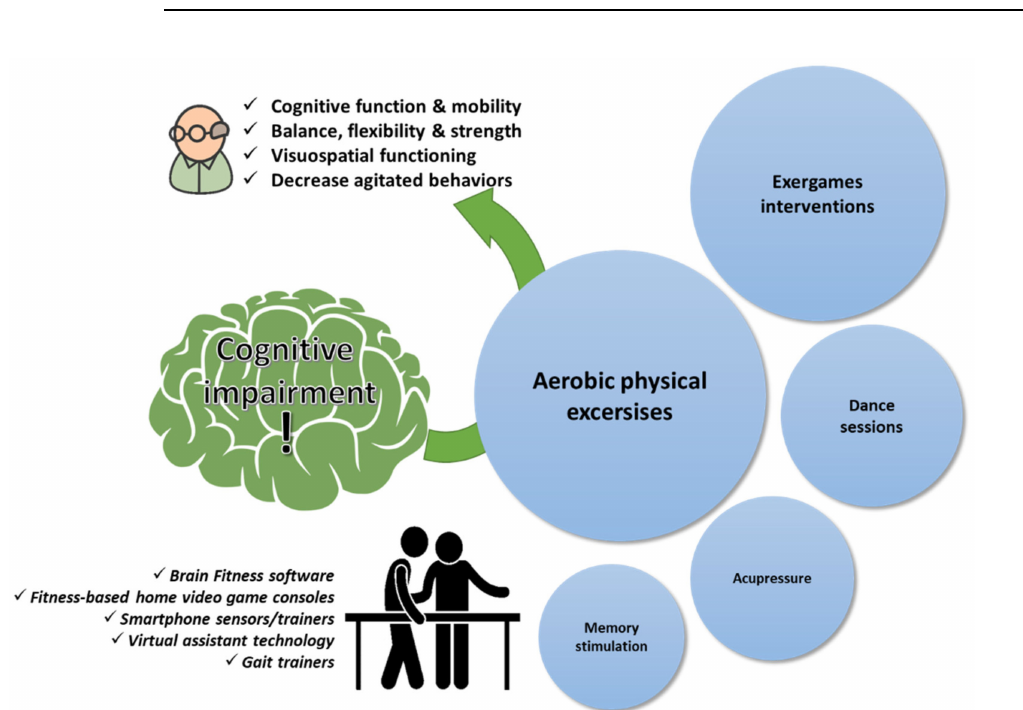
Figure 3. Physiotherapy goals in age-related cognitive impairment. A qualitative infographic of clinical trials in the literature regarding physiotherapy approaches in elders managing cognitive impairment with the incorporation of several pieces of state-of-the-art